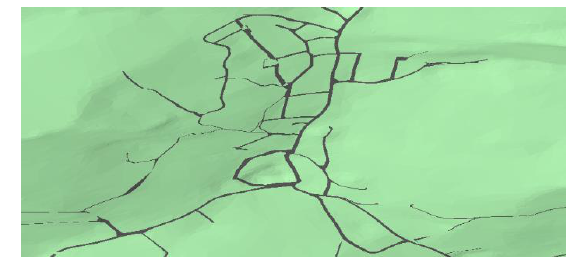
Figure 12. LOD2, Transportation network